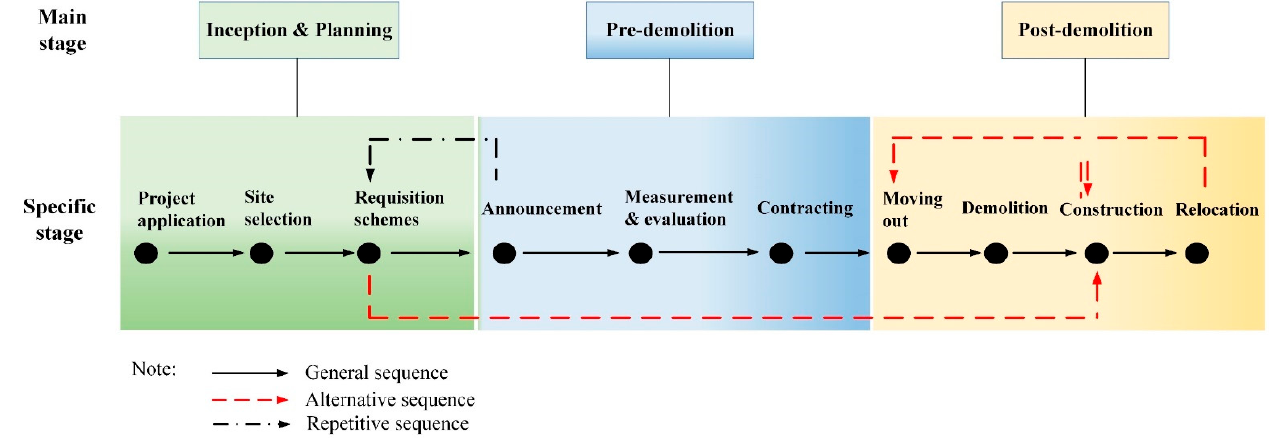
Figure 3. The redevelopment process of UVRPs.